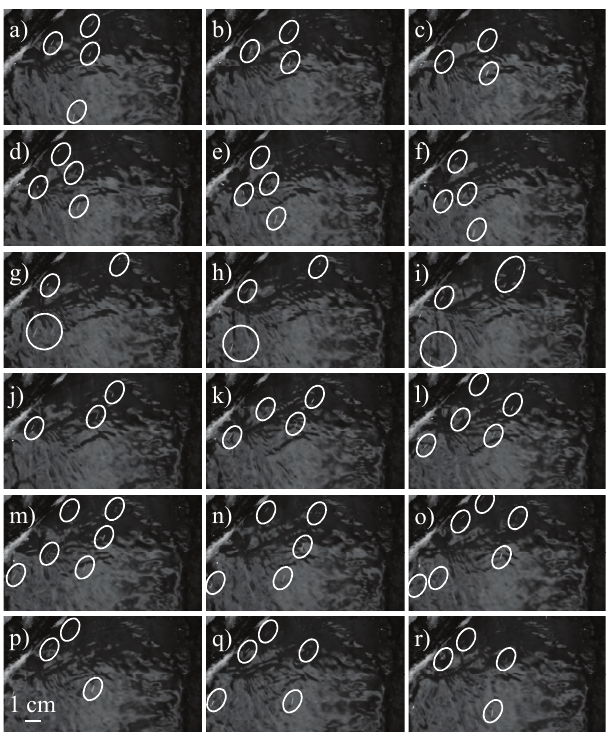
Fig.8. Sequenceofsnapshotsdepictingthetransitofsingleparticlesflowingintherillbelowthedetectionapparatus. Diametersofthe beadsareintherange 1000 (cid:0) 1180 (cid:22) m .Onlythegreenchannelisreportedforclarity. Fig. 8. Sequence of snapshots depicting the transit of single parti- cles flowing in the rill below the detection apparatus. Diameters of the beads are in the range 1000–1180µm. Only the green channel is reported for